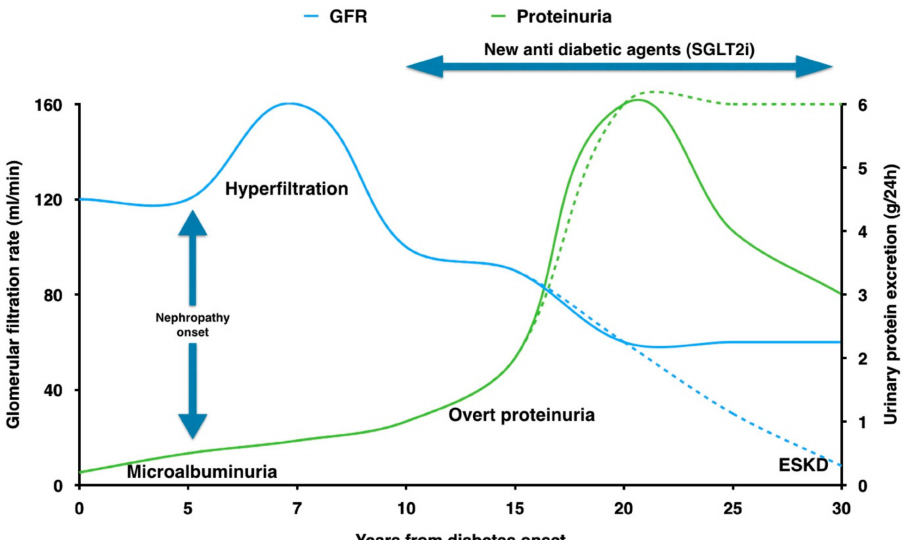
Figure 1. Natural history of diabetic nephropathy, dashed lines (modified from [8]): after an initial phase of hyperfiltration at the onset of diabetic kidney disease, the kidney function (glomerular filtration rate) slowly decreases over the years as proteinuria increases. This hyperfiltration phase is often missed and patients are referred to nephrologists once the glomerular filtration rate is already reduced or an overt proteinuria develops. Solid lines represent the modulation of the natural course of diabetic kidney disease by new treatment options. GFR: glomerular filtration rate; SGLT2i: sodium glucose transporter 2 inhibitors; ESKD: end-stage kidney